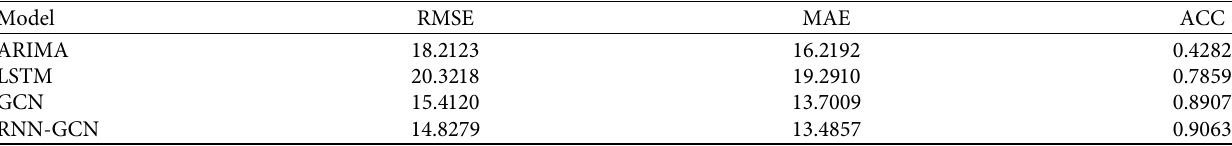
Table 5: Performance comparison of different